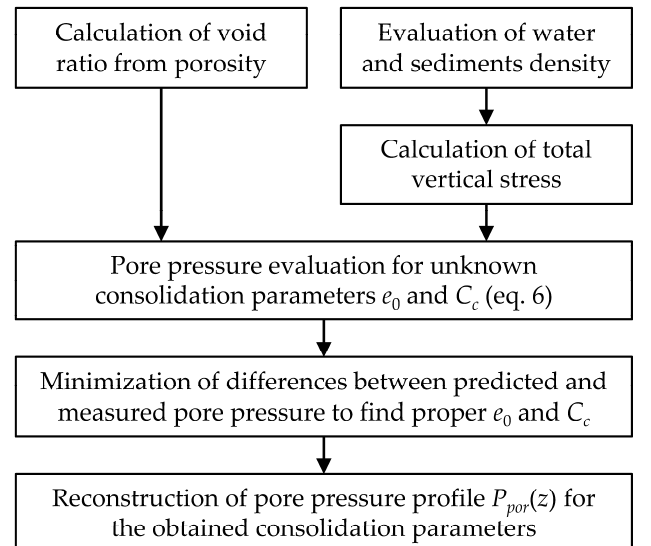
Figure A1. Flowchart for the determination of pore pressure through consolidation analysis. A flowchart for the forward problem solution—determination of elastic wave velocities from the model parameters—is shown in Figure